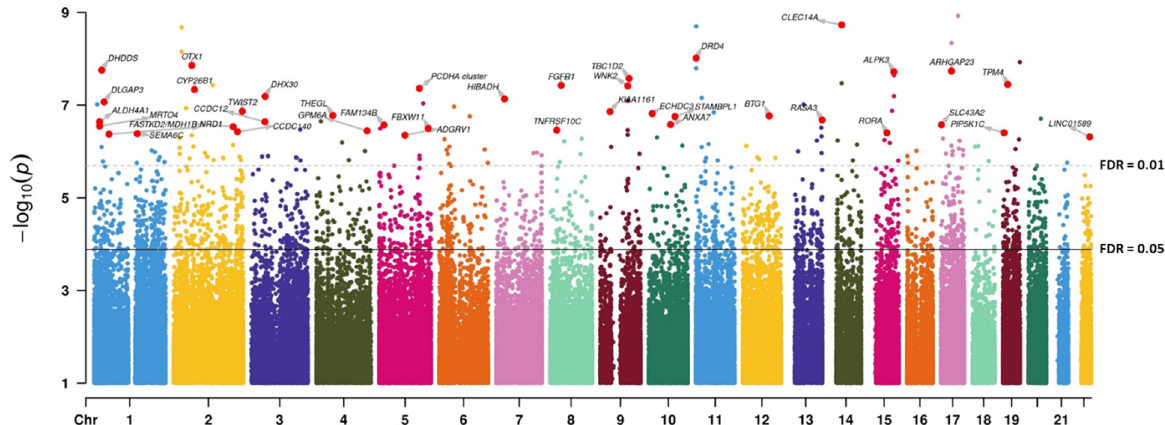
Figure 2. Manhattan plot representing the association between DNAm at the CpG level and high- grade (>1) vs. low-grade meningiomas. The dashed and solid lines indicate FDR thresholds after p -value correction for genome-wide multitesting (Benjamini–Hochberg). FDR: false discovery rate.